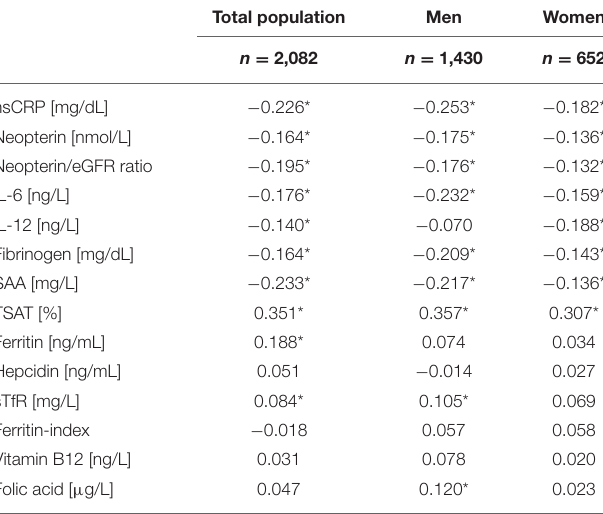
TABLE 2 | Spearman-rank correlations with